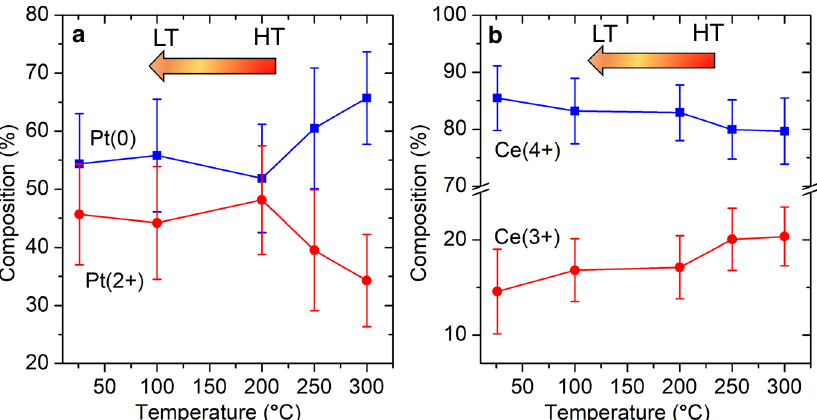
Fig. 5 AP-XPS studies of Pt nanoclusters supported on ceria. The valence state change of a Pt and b Ce under WGS conditions when the temperature drops from 300 °C (high temperature (HT)) to RT (low temperature (LT)). The standard deviation errors obtained from fi tting peak areas are also shown. The corresponding Pt 4 f and Ce 3 d region XPS experimental and fi tting spectra are shown in Supplementary Fig. 7.